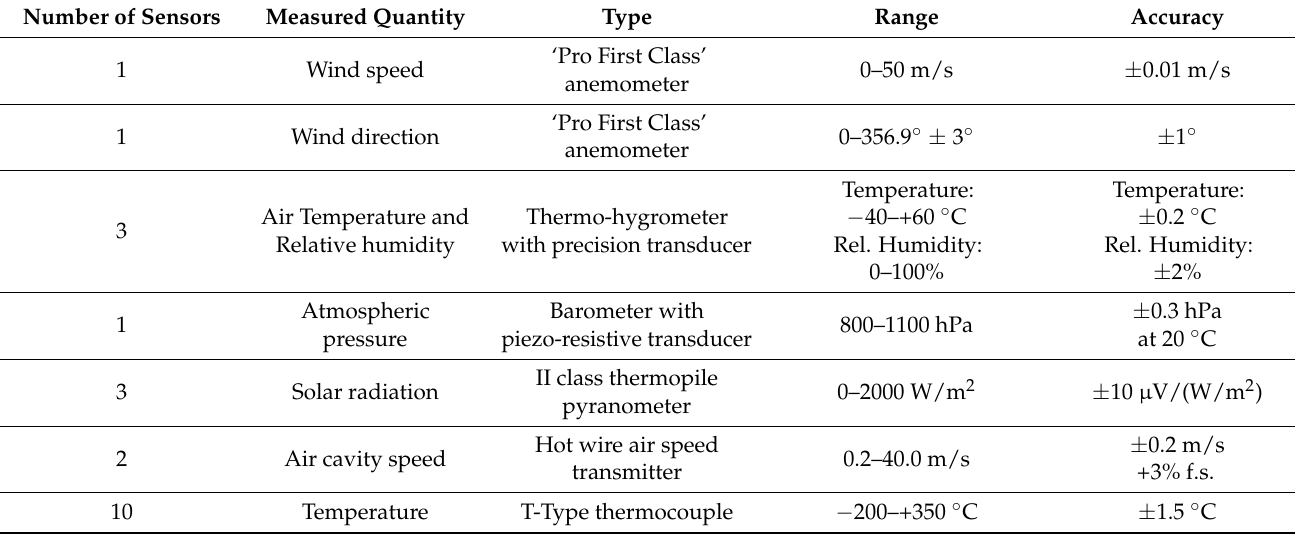
Table 1. Installed Gemini sensor measurement range and